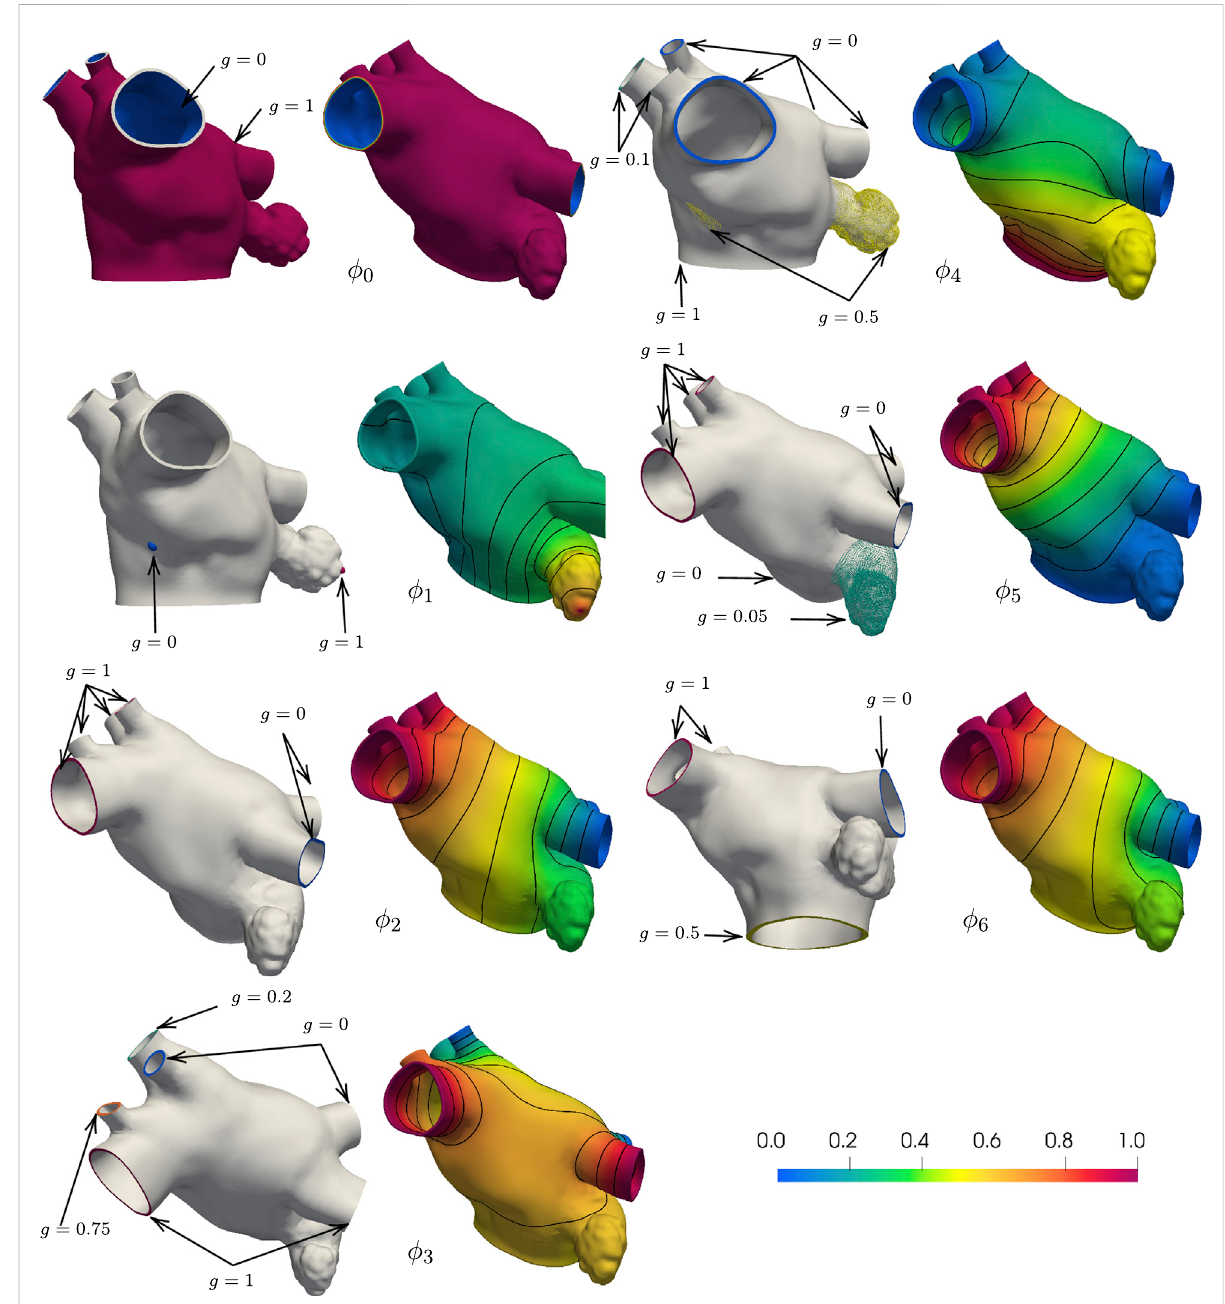
FIGURE 2 Boundary conditions and corresponding harmonic fi elds for M75. The fi eld ϕ 0 captures the distance from the endocardial and epicardial surfaces,respectively g =0and g =1,anditsgradientde fi nesthetransmuraldirection s .Imposing g =0 atthetipoftheLAAand g =1 atthecenterof theFO,the fi eld ϕ 1 sweeps fromtheLAAtotheFO. Setting g =0ontheleftPVsand g =1ontherightPVs,the fi eld ϕ 2 de fi nethe fi bersontheanterior and posterior walls. With g = 1 on the superior PVs and g = 0 on the inferior PVs and intermediate values on the auxilliary PVs, the fi eld ϕ 3 separates the anterior and posterior walls. The fi eld ϕ 4 de fi nes the Bachmann ’ s bundle, imposing g = 1 on the MV ring, g = 0.5 in the LAA and FO regions, and g =0onthemajorPVsand g =0.1ontherightmiddlePVs.The fi eld ϕ 5 identi fi estheleftandrightantras setting g =0ontheleftPVsand MV ring, g = 0.5 on the LAA, and g = 1 on the right PVs. The fi eld ϕ 6 de fi nes the fi ber direction in the anterior wall, setting g = 0 on the left PVs, right inferior PV, and around the MV ring, g = 0.05 on the LAA, and g = 1 on the right